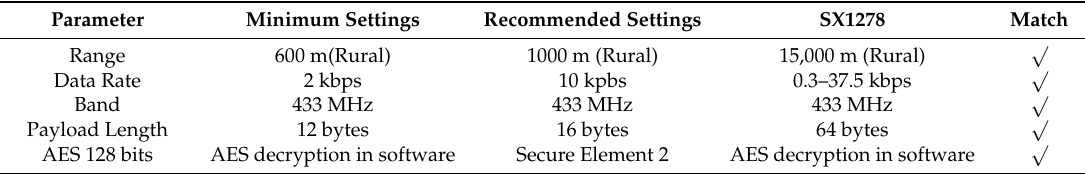
Table 5. Module SX1278 technical requirements for sensors [16].